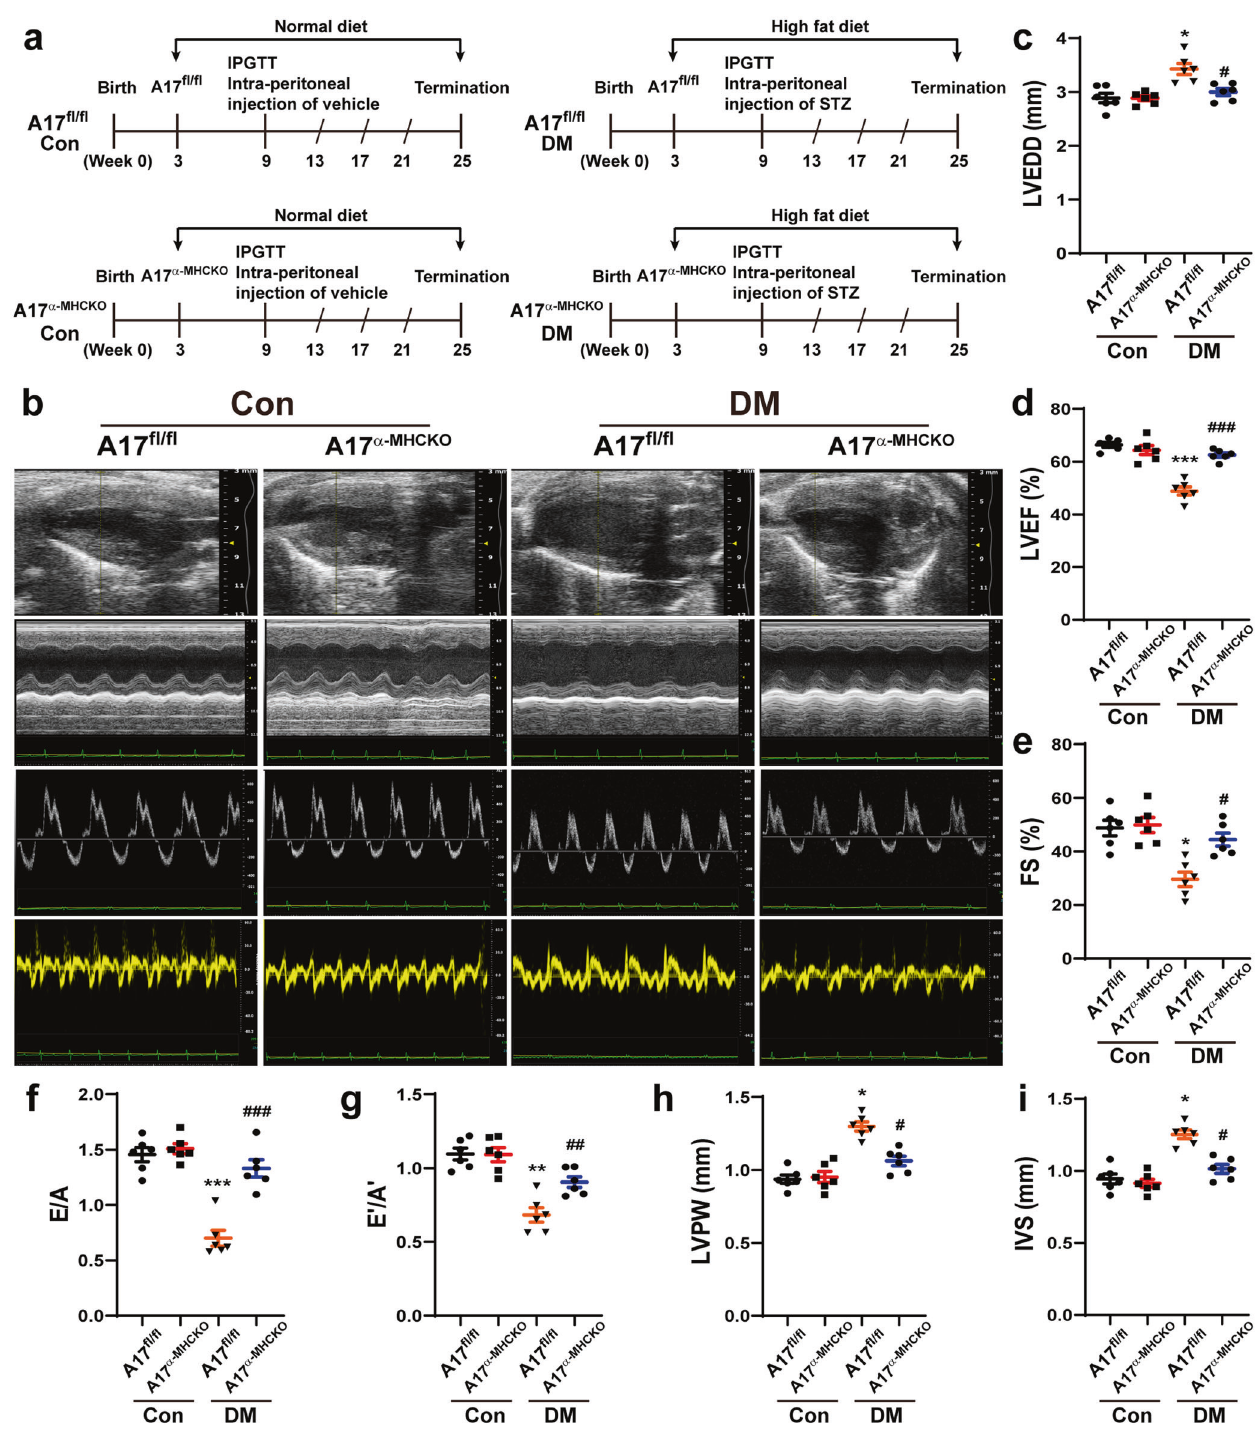
Fig. 1 Experiment timeline and echocardiographic measurements in four groups of mice. a Experiment timeline in four groups of mice. b Representative echocardiographic images in mice: (1) Two-dimensional echocardiogram showing left ventricular long-axis view; (2) M-mode echocardiogram showing left ventricular dimensions; (3) Pulse-wave Doppler echocardiogram depicting diastolic mitral fl ow; (4) Tissue Doppler echocardiogram displaying mitral annular velocities. c Measurements of left ventricular end-diastolic diameter (LVEDD) in mice. d Measurements of left ventricular ejection fraction (LVEF) in mice. e Measurements of left ventricular fractional shortening (FS) in mice. f Measurements of the ratio of early to late diastolic mitral fl ow velocities (E/A) in mice. g Measurements of the ratio of early to late diastolic mitral annular velocities (E'/A') in mice. h Measurements of left ventricular posterior wall (LVPW) thickness in mice. i Measurements of interventricular septum (IVS) thickness in mice. Data were expressed as mean ± SEM. * P < 0.05, ** P < 0.01, *** P < 0.001 vs. the A17 fl / fl control group; # P < 0.05, ## P < 0.01, ### P < 0.001 vs. the A17 fl / fl DM group; n =